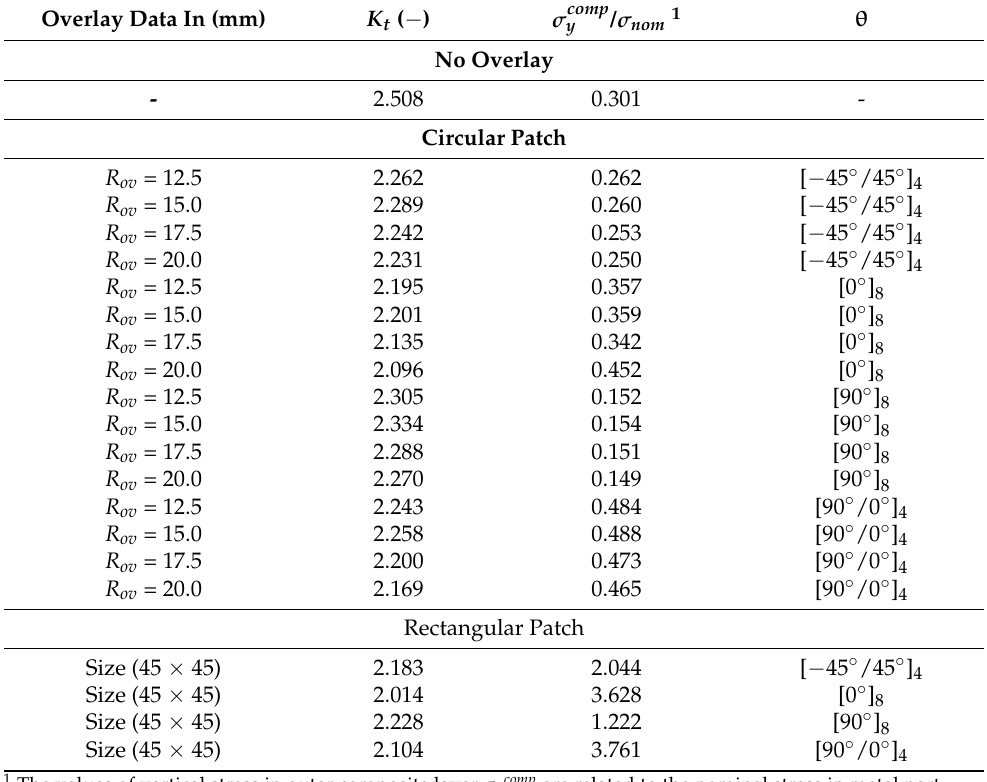
Figure 31. Square patch 45 × 45, distribution of tension stress σ y : for different angle of fiber orientation. Table 5. Numerical results, Hexcel TVR380, width W = 45 mm, plate thickness t = 4